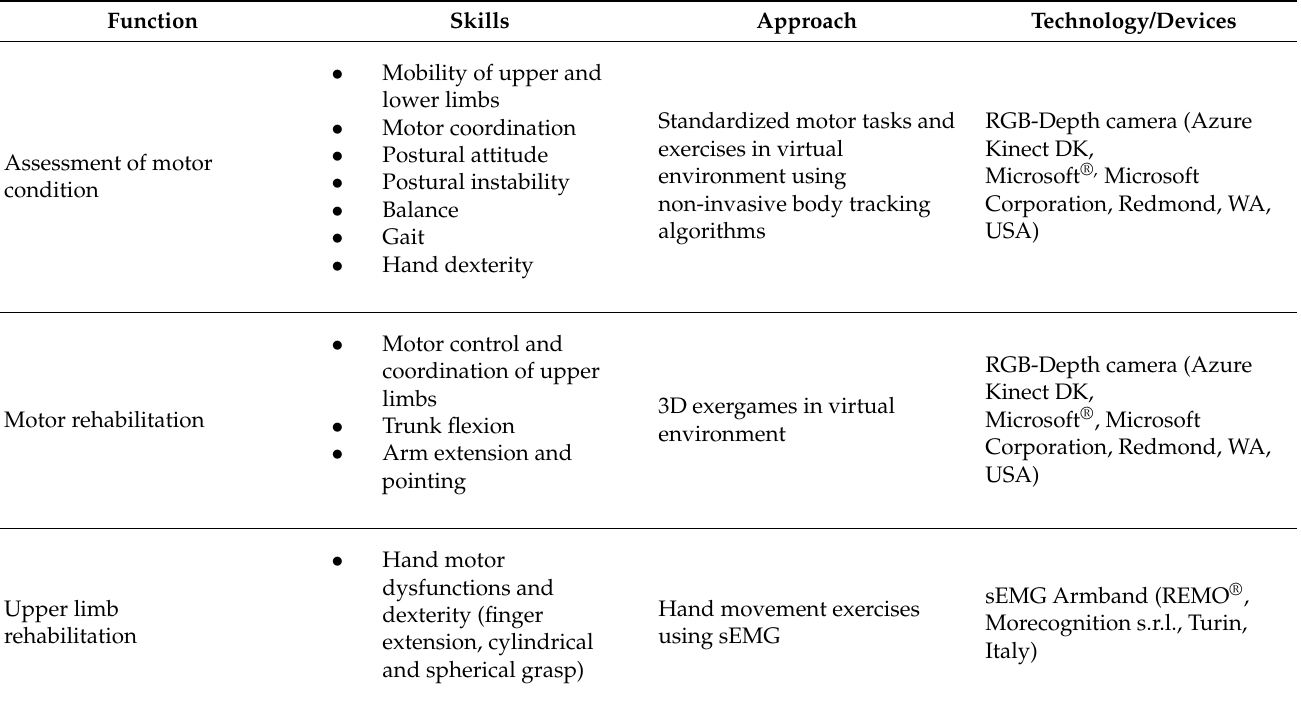
Table 2. Summary of the main functionalities of the